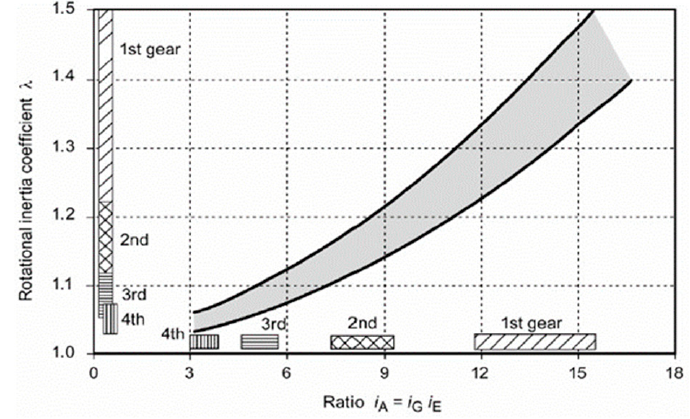
Figure 12. Behavior and Typical Values for the Rotational Inertia Coefficient, C i [110].